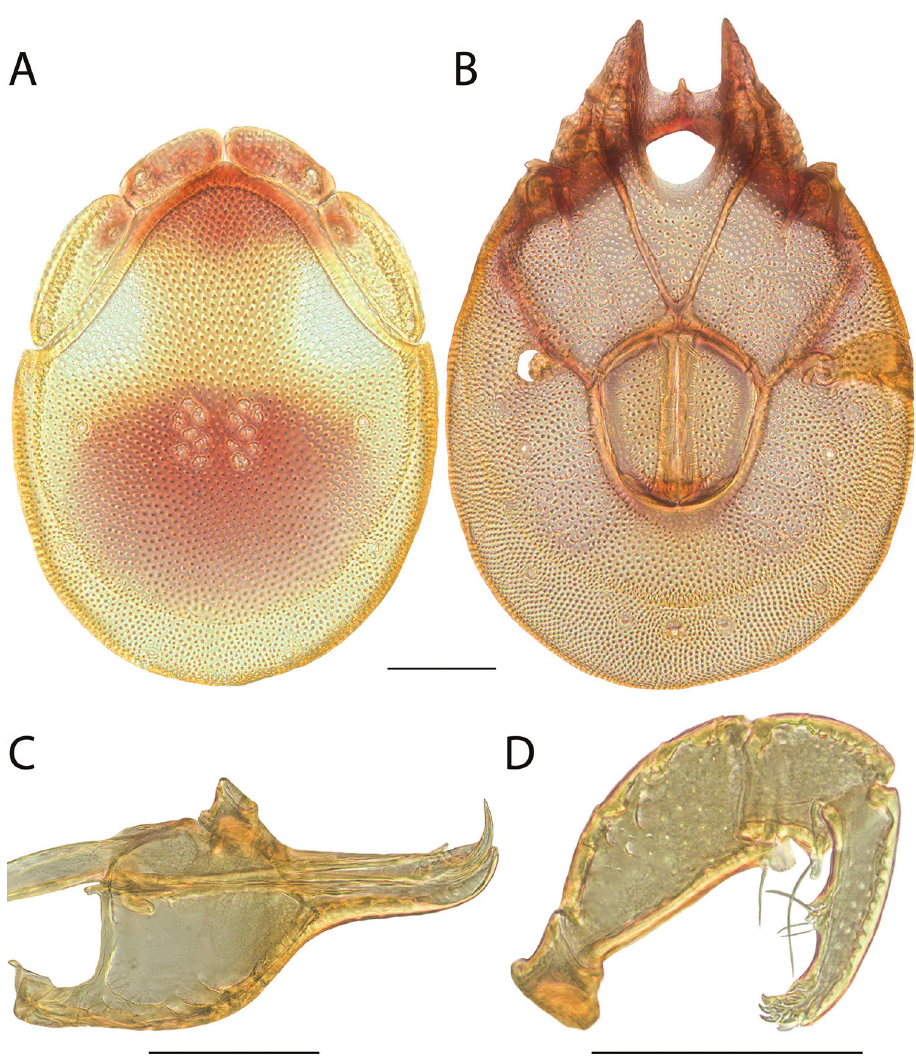
Figure 244. Torrenticola skvarlai sp. n. female: A dorsal plates B venter (legs removed) C subcapitulum D pedipalp (setae not accurately depicted). Scale = 100